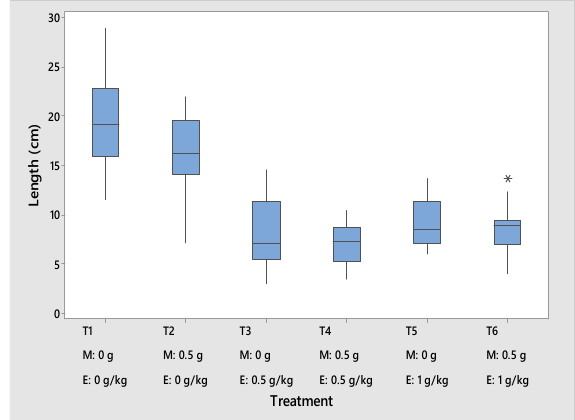
Figure 3. Root lengths of plants in the different treatments. M, mycorrhizae; E, EDTA; the asterisk indicates values that are far from normal